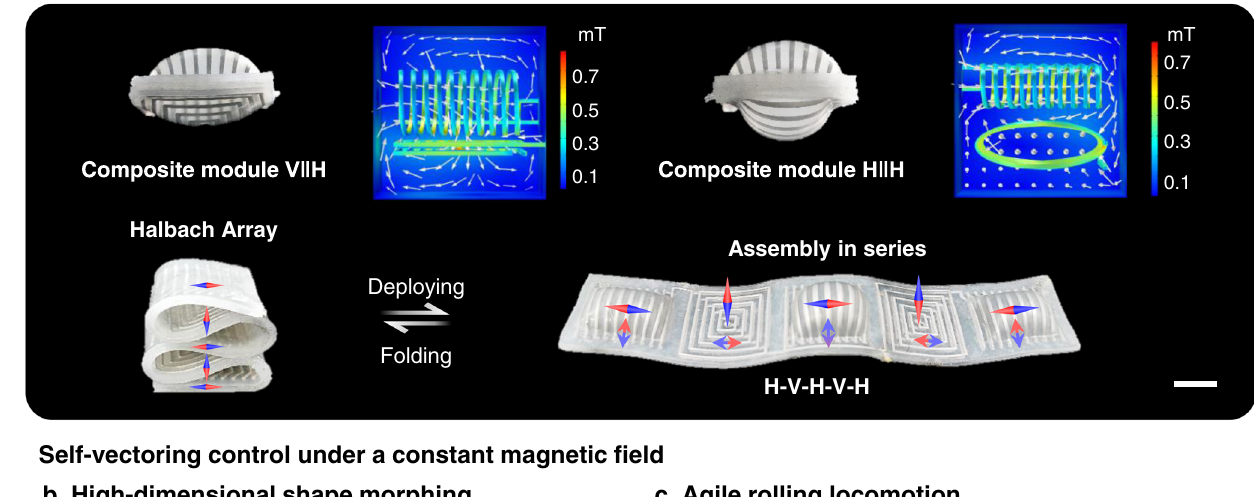
assembled by three composite modules V||H in parallel. Every ‘ leaf ’ can demon- strate three modes of deformations including bend, twist, bend and twist under control of two signals. Scale bar=20mm. c Demonstration of the agile rolling locomotionofasingleHmoduleanditscompositemodule.AsinglemoduleHcan roll continuously on rugged terrains controlled by only one current signal, scale bar=20mm. The composite module H||H can realize omnidirectional rolling on the magnet surface controlled only two current signals, scale